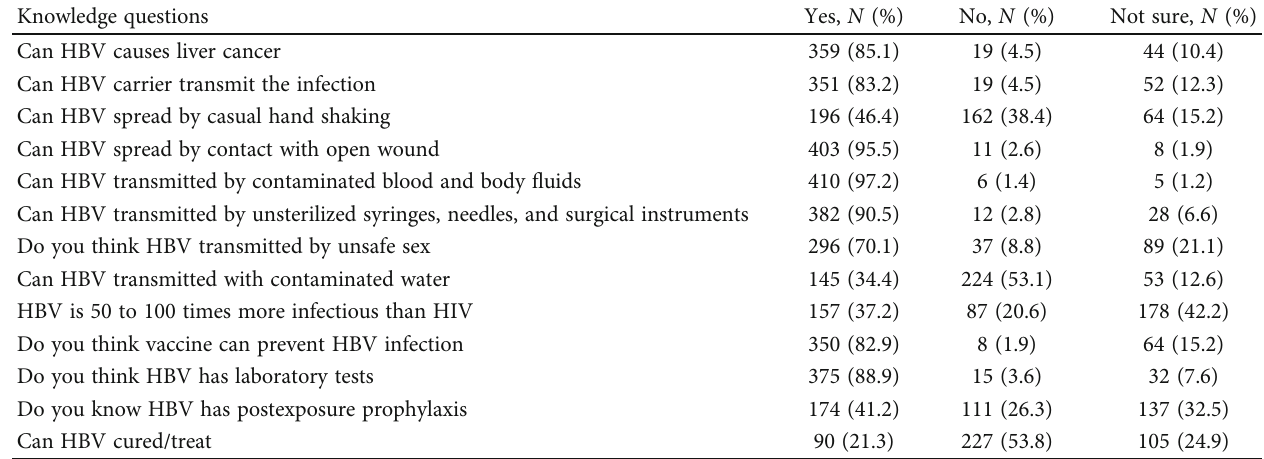
Table 2: Knowledge-related questions about HBV early detection, transmission, and